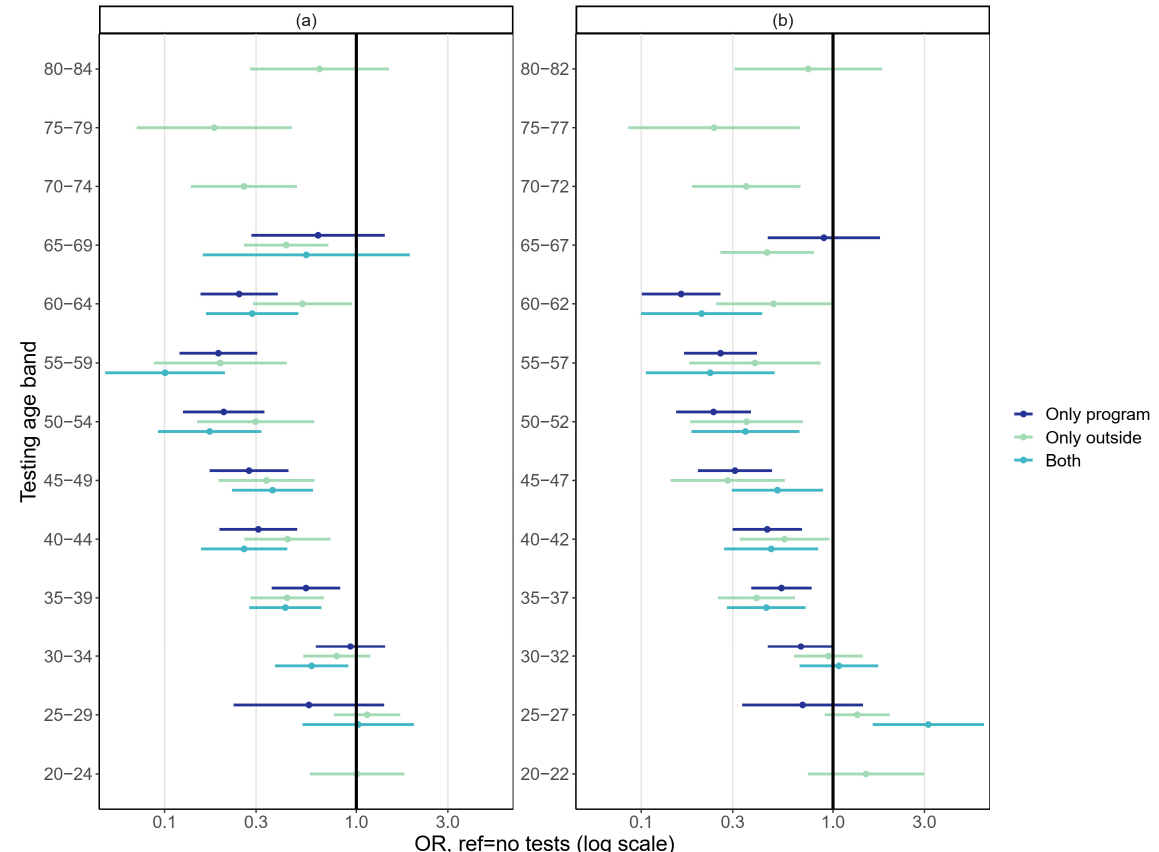
Figure 4. Association between testing by ( a ) a five-year testing age band and ( b ) a three-year testing age band and cervical cancer diagnosis in the following five-year interval. Adjusted for education, socioeconomic status, and mother tongue.